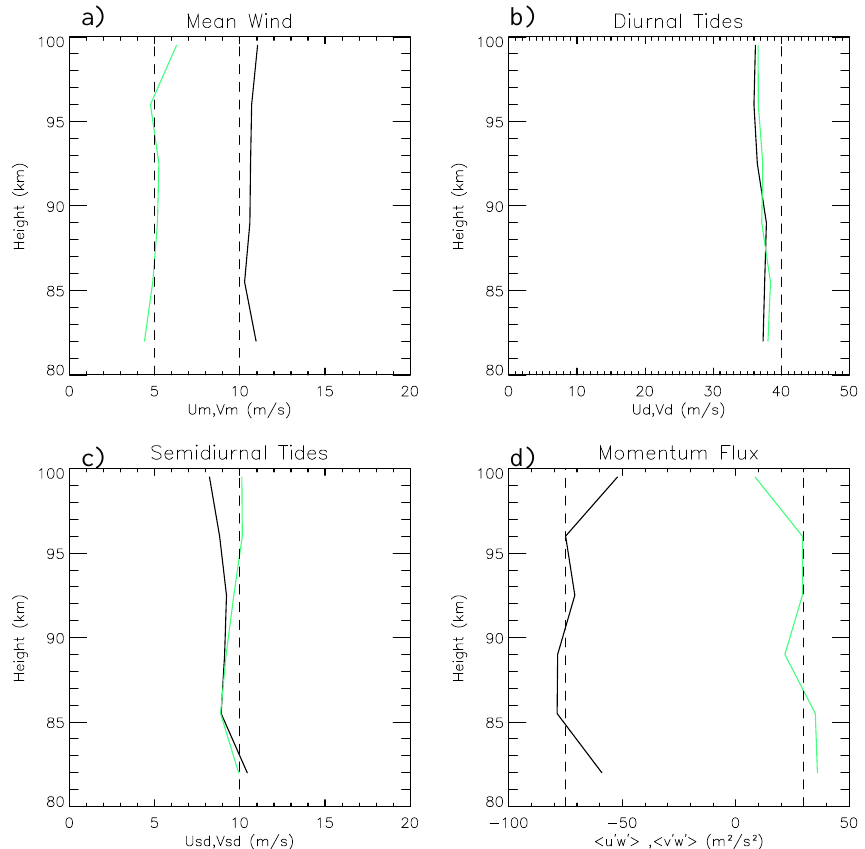
Fig. 13. As in Fig. 12, but for (a) mean winds, (b) and (c) diurnal and semidiurnal tides, and (d) the superposition of the zonal and meridional propagating GWs and stationary GWs (see Case 2 in Table